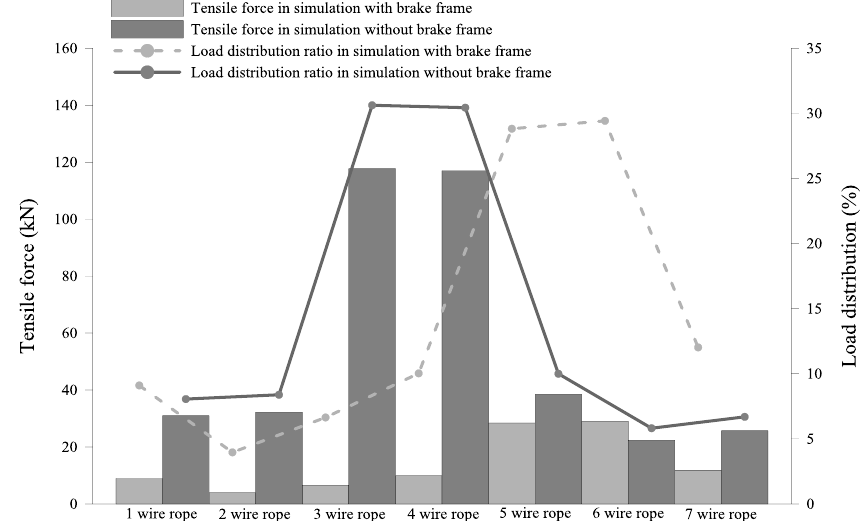
Figure 16. Comparison of the development of tensile forces and load distribution in each wire rope with and without using a brake frame.